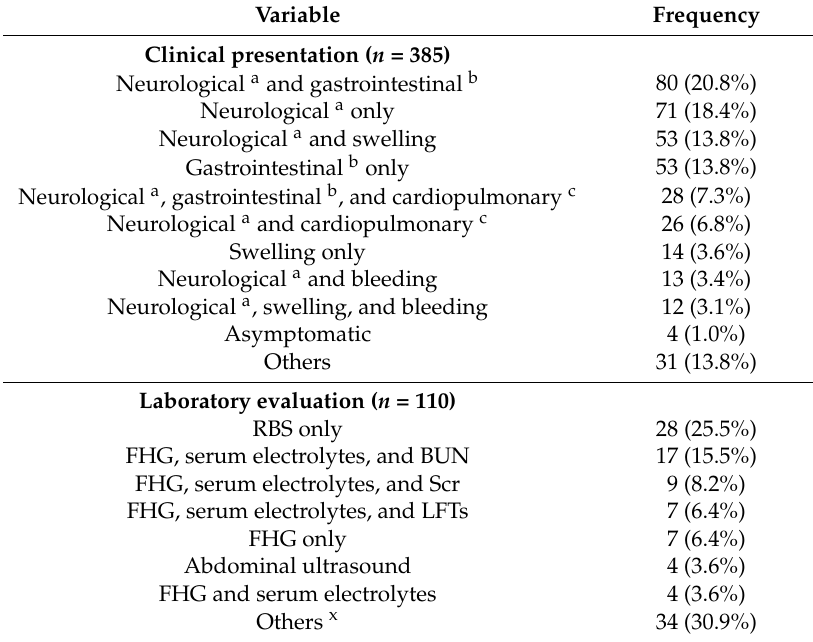
Table 6. Symptomatology and laboratory evaluations among